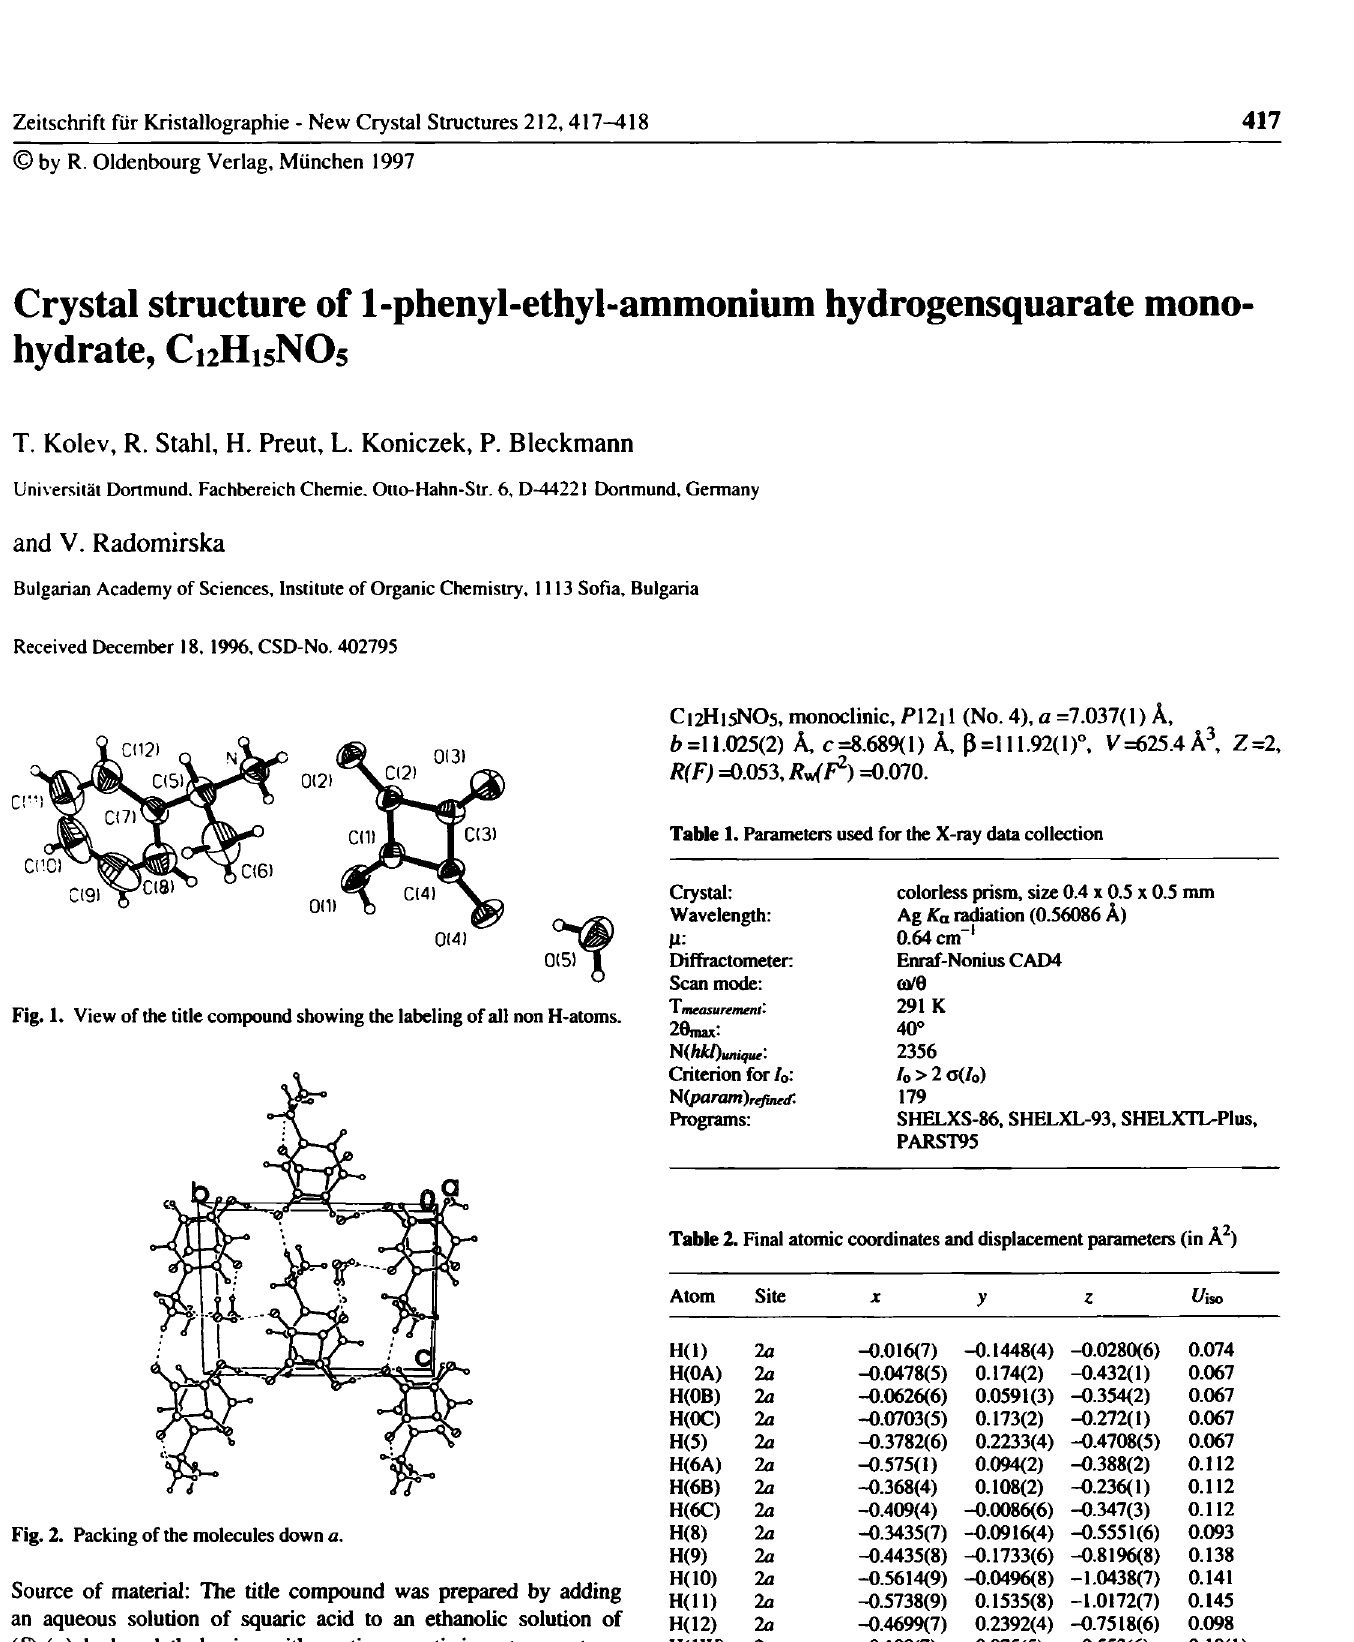
Fig. 2. Packing of the molecules down a.